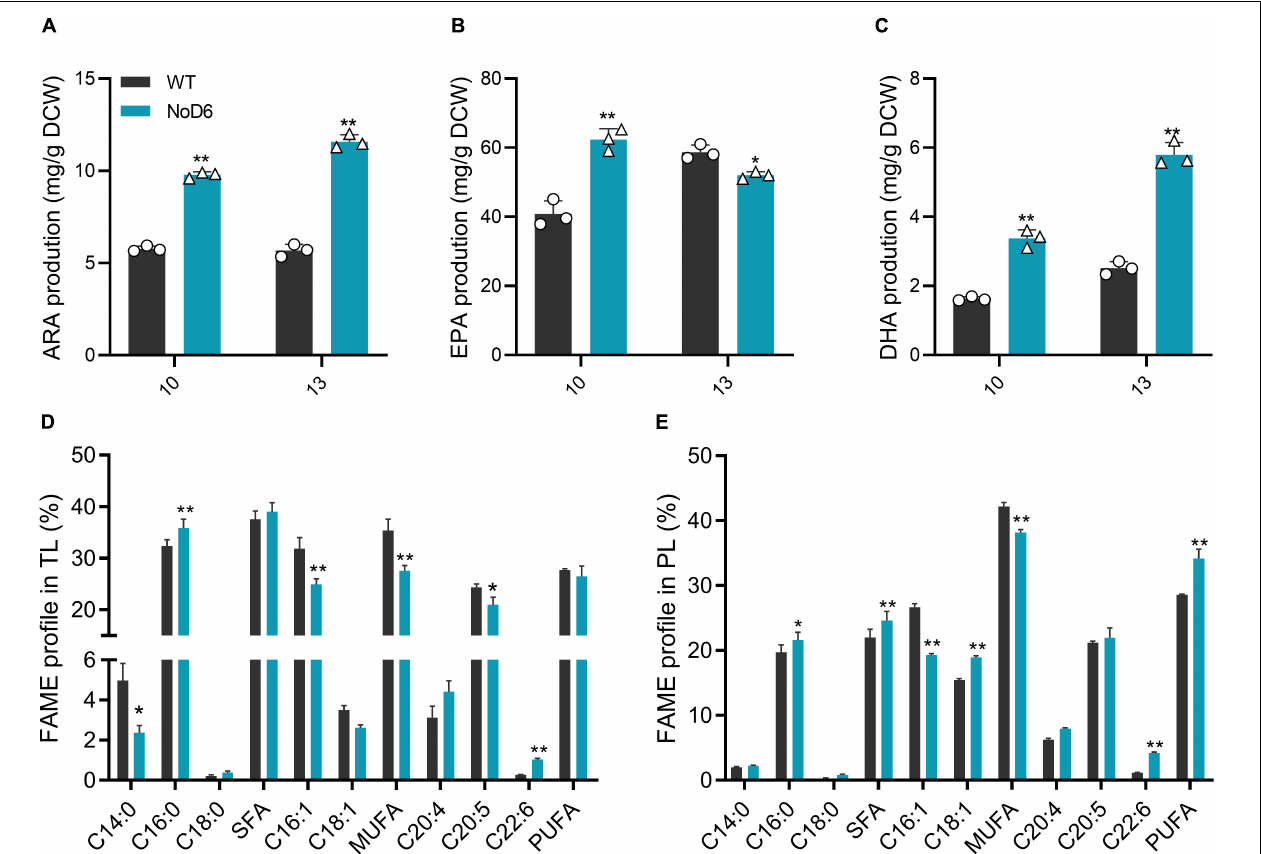
FIGURE 3 | Fatty acid analysis. (A) Arachidonic acid content (mg/g DCW). (B) Eicosapentaenoic content (mg/g DCW). (C) Docosahexaenoic acid content (mg/g DCW). (D) Fatty acid composition in total lipids (%). (E) Fatty acid composition in total phospholipid (%). Significant difference is indicated at ∗ p < 0.05 or ∗∗ p < 0.01 level. Each value represents means ± SD ( n =